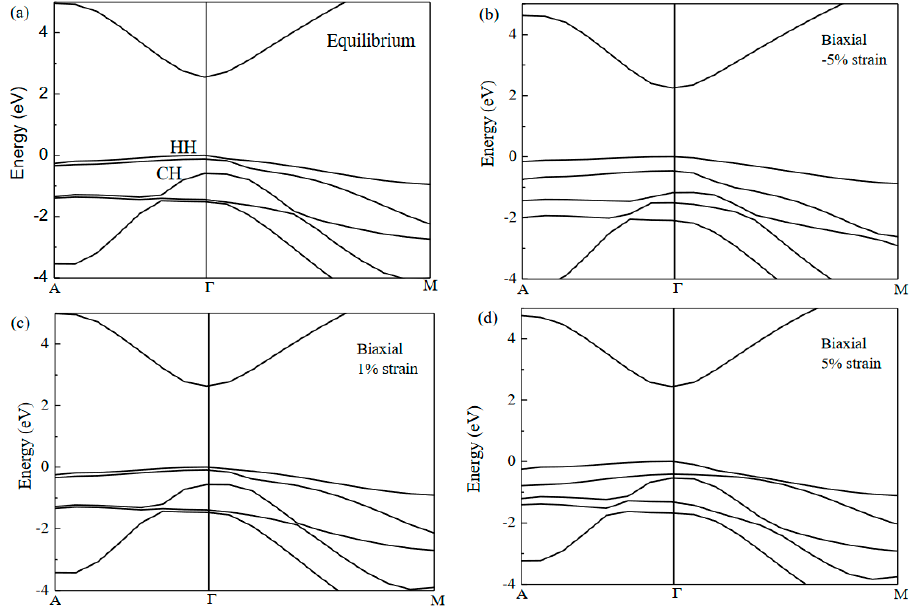
Figure 4. Band structures of WZ In 0.5 Al 0.5 N at ( a ) equilibrium, ( b ) biaxial compressive strain of − 5%, ( c ) biaxial tensile strain of 1%, and ( d ) biaxial tensile strain of 5% in (0001) plane after free relaxation. The band structure changes significantly with the application of the biaxial